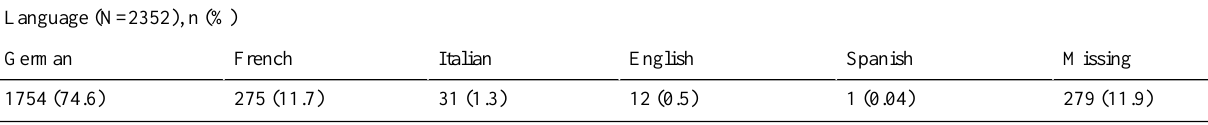
Table 2. Distribution of rejected feedback according to language. Language (N=2352), n (%) MissingSpanishEnglishItalianFrenchGerman